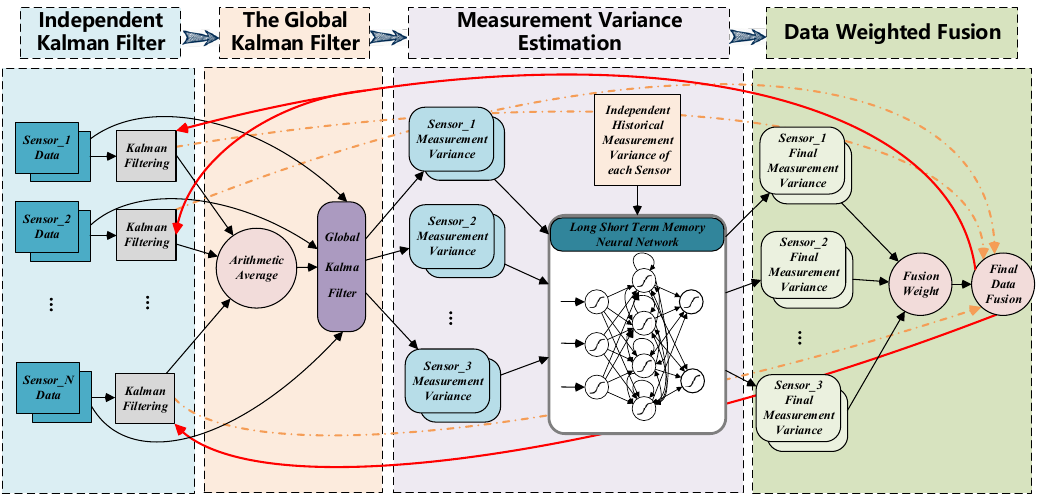
Figure 2. The operation process architecture of